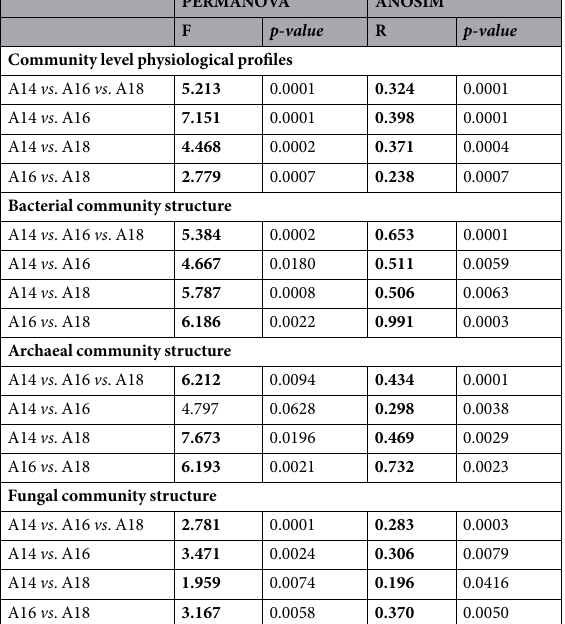
Table 2. Results of global (considering the three layers) and pairwise (considering each pair of layers) PERMANOVA (permutational analysis of variance) and ANOSIM (analysis of similarities) of community level physiological profiles (CLPPs) and OTU-based bacterial, archaeal and fungal community structures found in the studied layers A14 (upper), A16 (intermediate) and A18 (lower). F and R values in bold denote statistical significance (p ≤ 0.05).